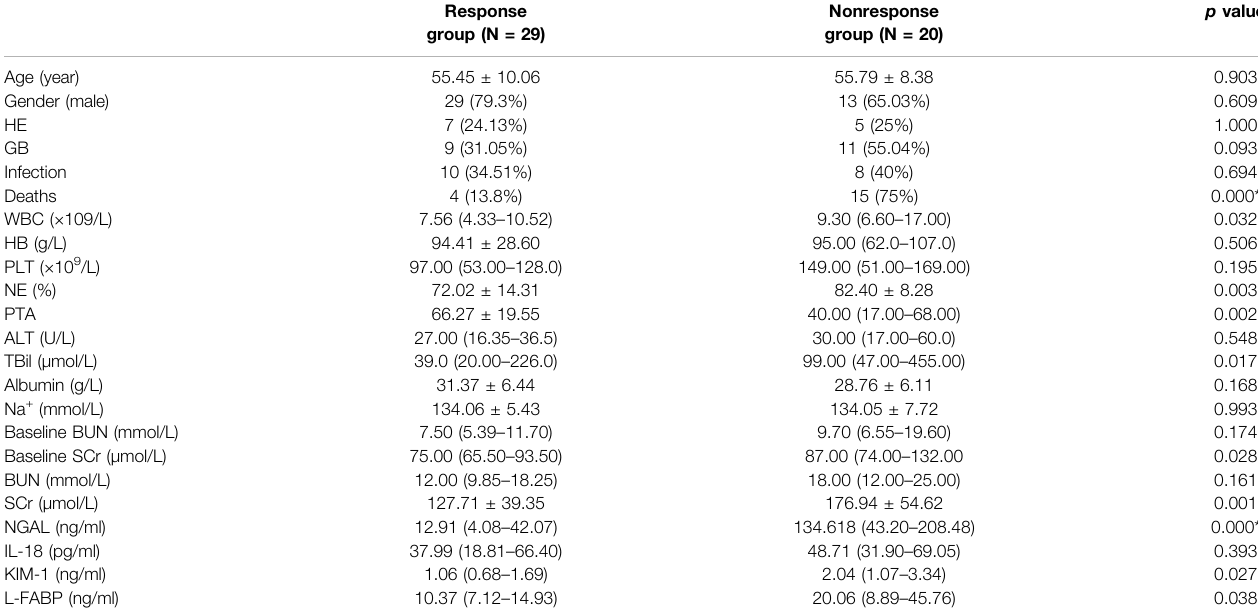
TABLE 2 | Characteristics of patients in the response and nonresponse group to volume expansion therapy in patients with cirrhosis and AKI.